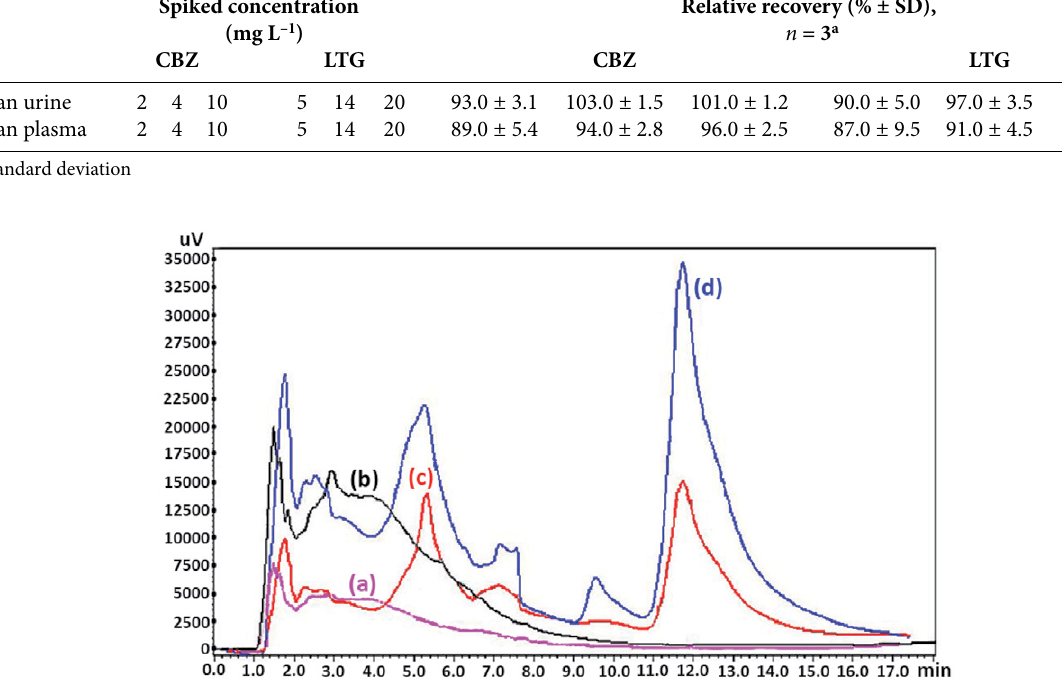
Table 2. Determination of carbamazepine (CBZ) and lamotrigine (LTG) in human plasma and urine by IL-DLLME-HPLC-DAD Spiked concentration